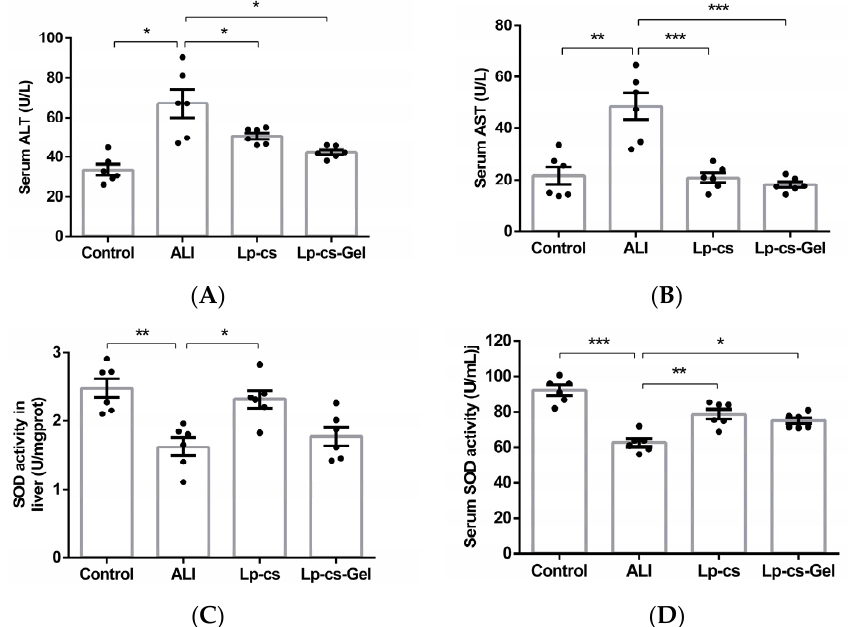
Figure 4. Evaluation of the liver oxidative damage in the control, ALI, LP-cs, and LP-cs-Gel-presupplemented groups: ( A ) Serum ALT levels in each group of mice, which were 33.63 ± 2.74, 67.00 ± 6.92, 50.68 ± 1.64, and 42.37 ± 1.25 U/L, respectively; ( B ) serum AST levels in each group of mice, which were 21.77 ± 3.43, 48.48 ± 5.28, 20.92 ± 1.89, and 18.26 ± 1.15 U/L, respectively; ( C ) SOD activity in the liver of the mice, which were 2.48 ± 0.14, 1.63 ± 0.13, 2.31 ± 0.13, and 1.78 ± 0.13 U/mg, respectively; ( D ) serum SOD activity in each group of mice, which were 92.07 ± 2.84, 62.47 ± 2.20, 78.68 ± 2.69, 74.96 ± 1.74, respectively. ALI, acute alcohol injury; LP-cs, Lactobacillus plantarum culture supernatant; LP-cs-Gel, LP-cs-loaded calcium alginate hydrogel. Data are presented as individual data points as well as the mean ± SEM for each group, with n = 6 per group. p -values were determined by one-way ANOVA. * p < 0.05, ** p < 0.01, and *** p < 0.001.